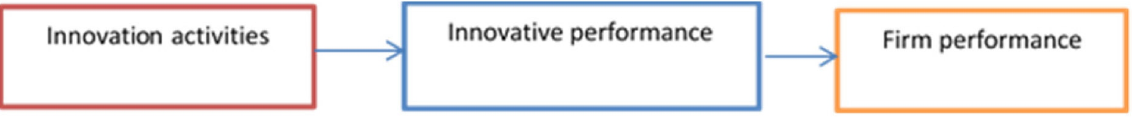
Figure 1. The conceptual framework of innovation and firm performance